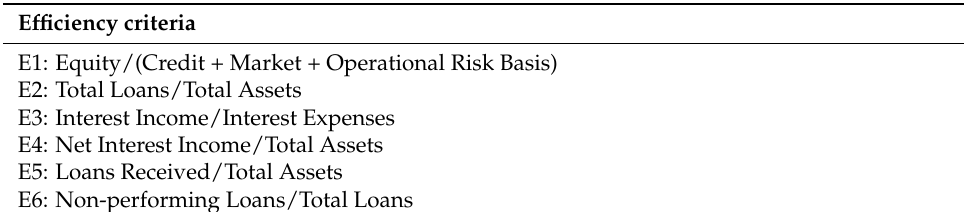
Table 3. Bank efficiency and productivity criteria.